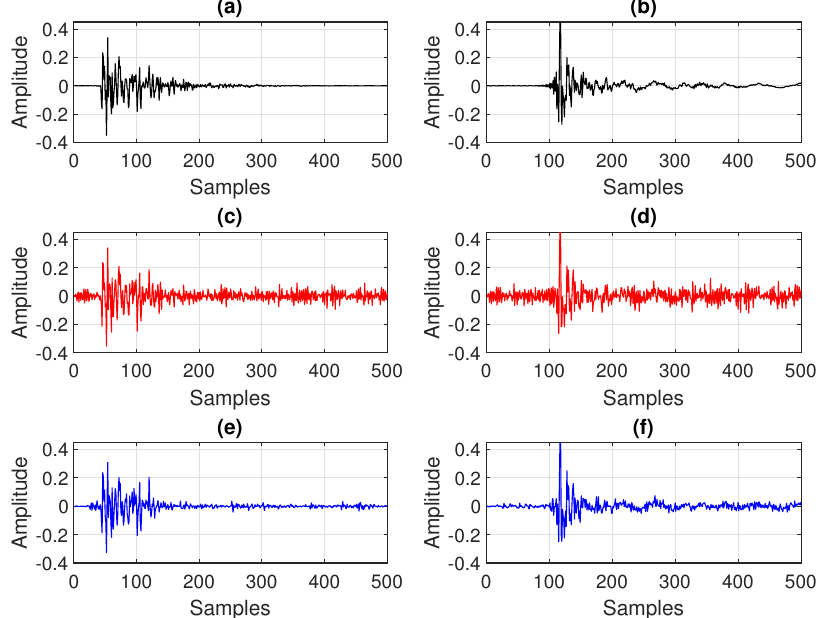
Figure 8. Performance of the conventional Wiener filter (WF) and the iterative Wiener filter (IWF) using P = 4, for the identification of the acoustic echo paths from Figure 1c,d. ( a ) The true acoustic impulse response from Figure 1c; ( b ) the true acoustic impulse response from Figure 1d; ( c ) estimated impulse response with the conventional WF, corresponding to Figure 1c; ( d ) estimated impulse response with the conventional WF, corresponding to Figure 1d; ( e ) estimated impulse response with the IWF, corresponding to Figure 1c; and ( f ) estimated impulse response with the IWF, corresponding to Figure 1d. Other conditions are the same as in Figure